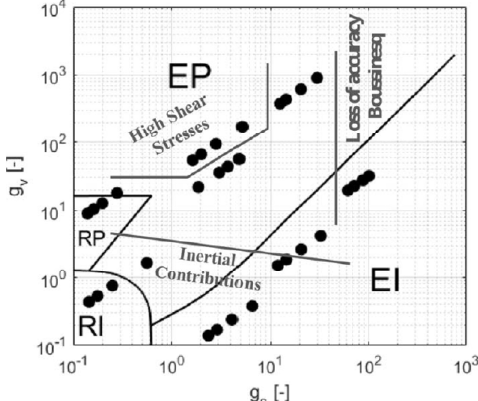
Fig. 50 Comparing results with and without iteration update process including the error control of flow continuity [851]. Reproduced with permission from Ref. [851], © American Society of Mechnaical Engineers, 2021.